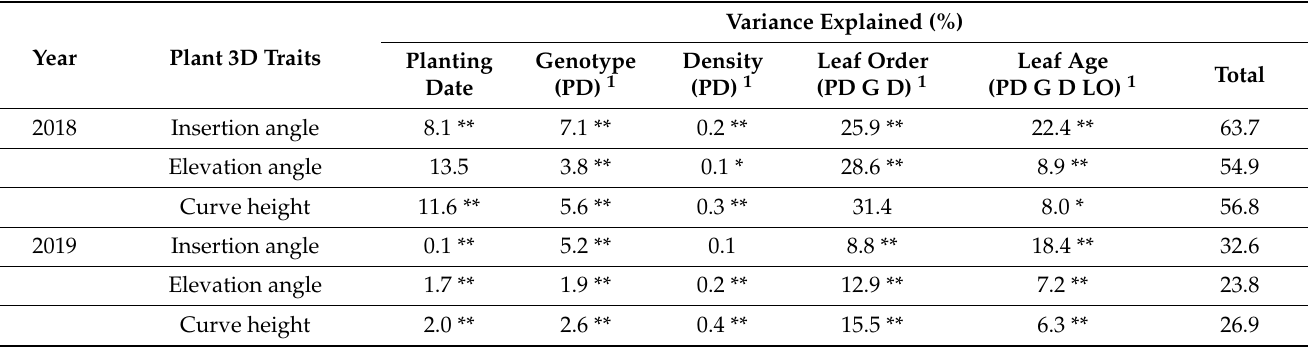
Table 2. Analysis of variance and percentage of variance explained by main and nested effects for insertion angle, elevation angle, and curve height (field-scanned leaves from tagged plants in 2018 and 2019).